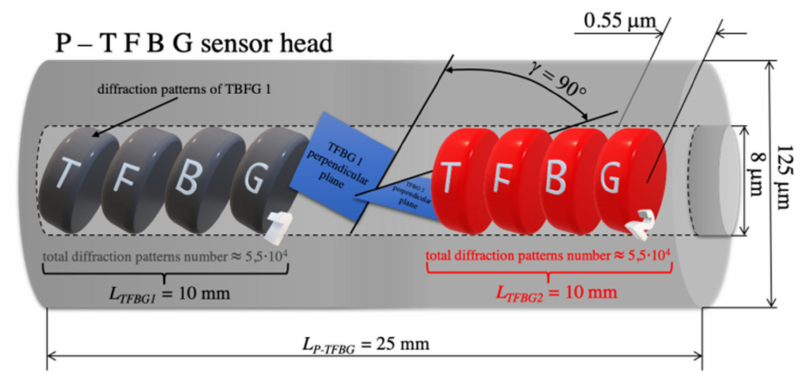
Figure 14. Idea of determining the γ angle in the P-TFBG structure.